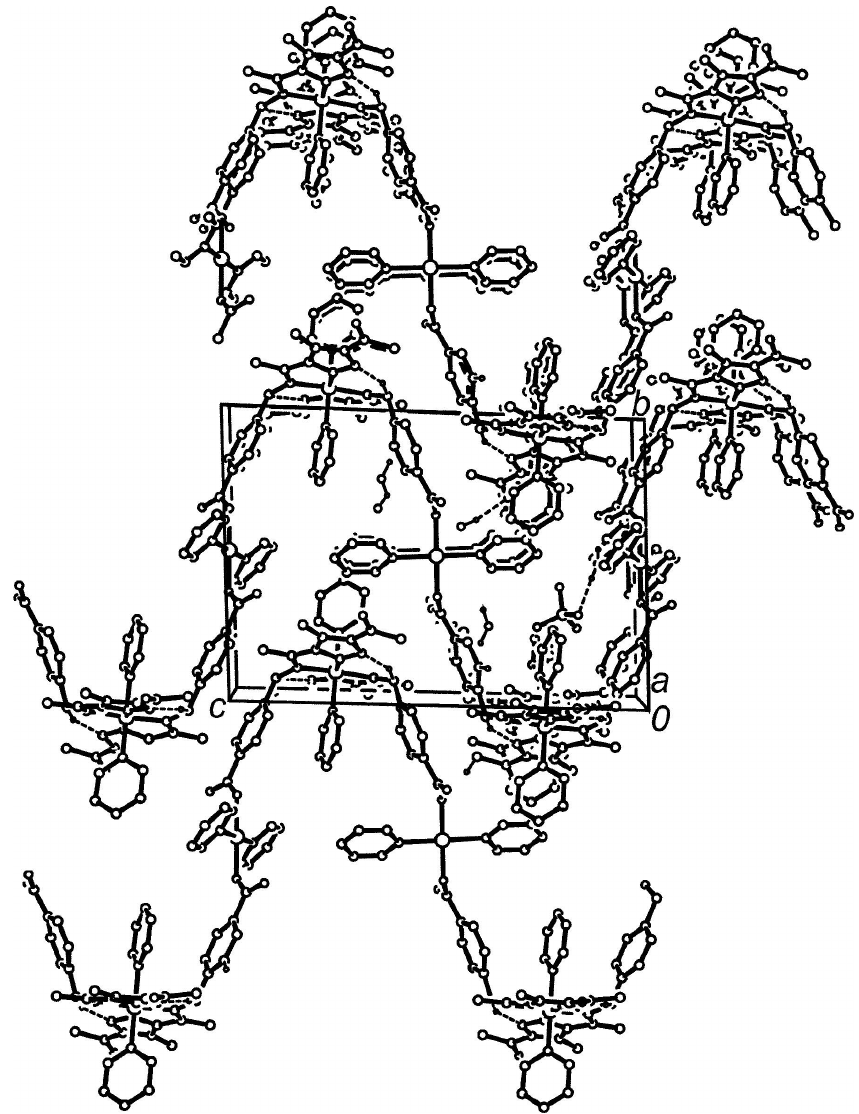
Figure 2 Crystal packing of (I). Disordered positions of the water molecules (O15 and O16) and H-atom not participating in hydrogen bonds are omitted for